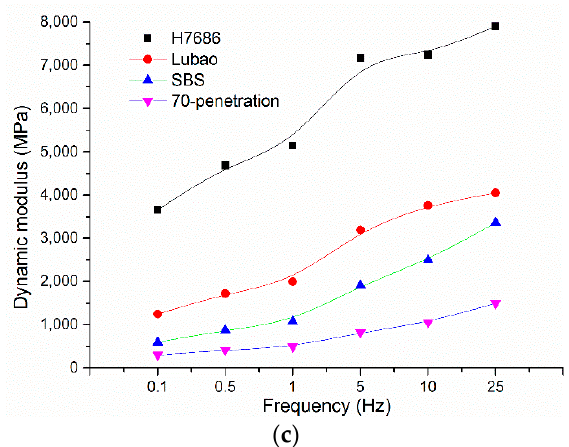
Figure 2. Dynamic modulus comparison results at different temperatures: ( a ) 5 ° C; ( b ) 20 ° C; ( c ) 45 ° C.